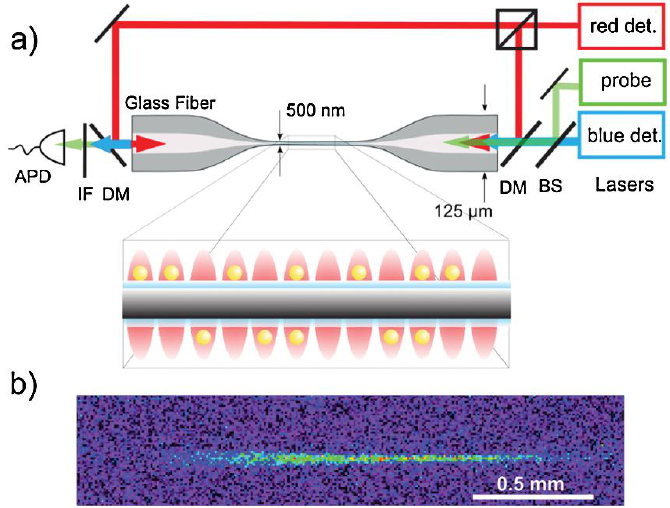
Figure 12. ( a ) Experimental setup of the ONF two-color atom trap. The blue-detuned running wave in combination with the red-detuned standing wave creates a trapping potential. A resonant laser is used for probing the atoms via the evanescent field. ( b ) Fluorescence image of the trapped atoms. Reprinted with permission from